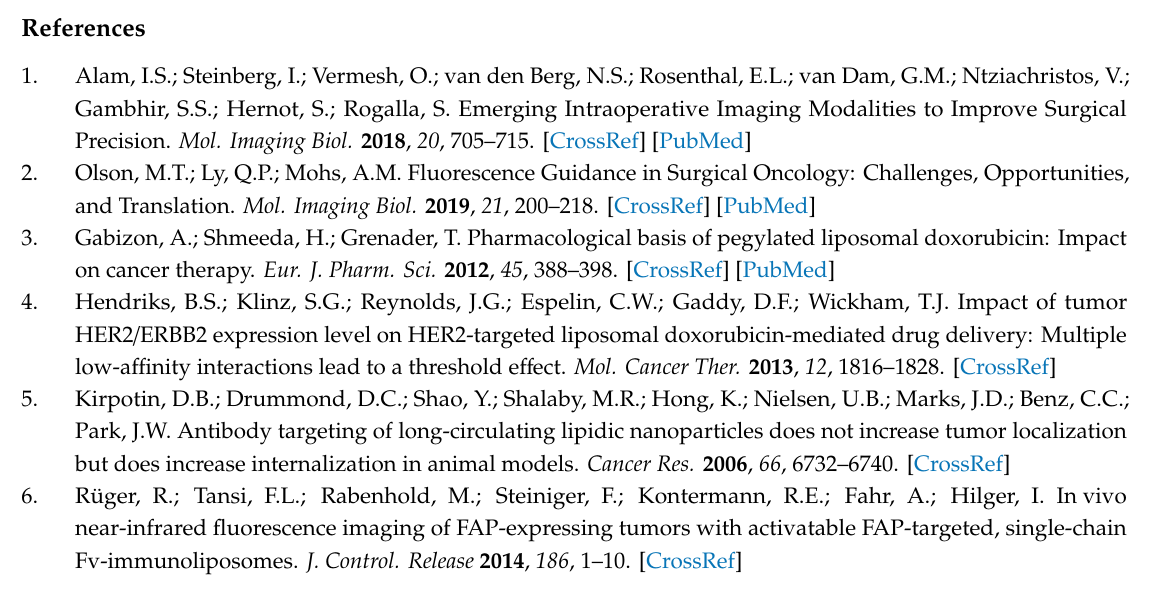
Table S1: Size increases of the liposomes were observed after post insertion of targeting antibodies, Figure S1: Relative levels of the vascular density of di ff erent xenograft models, Figure S2: Time course evaluations of liposomal uptake and cargo release in FAP expressing cells, Video S1: Material demonstrating the nuclear delivery of encapsulated DY676-COOH by Bi-FAP /